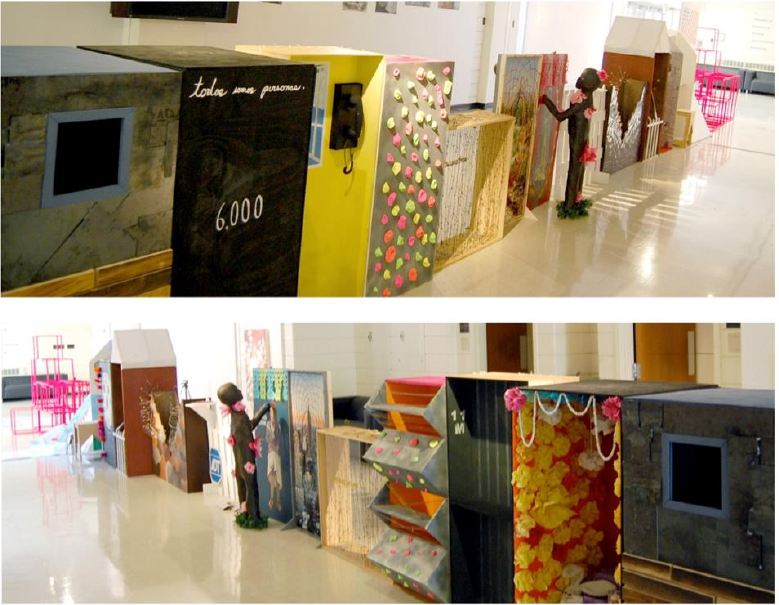
FIGURE 1: THIN EDGE OF BARBWIRE